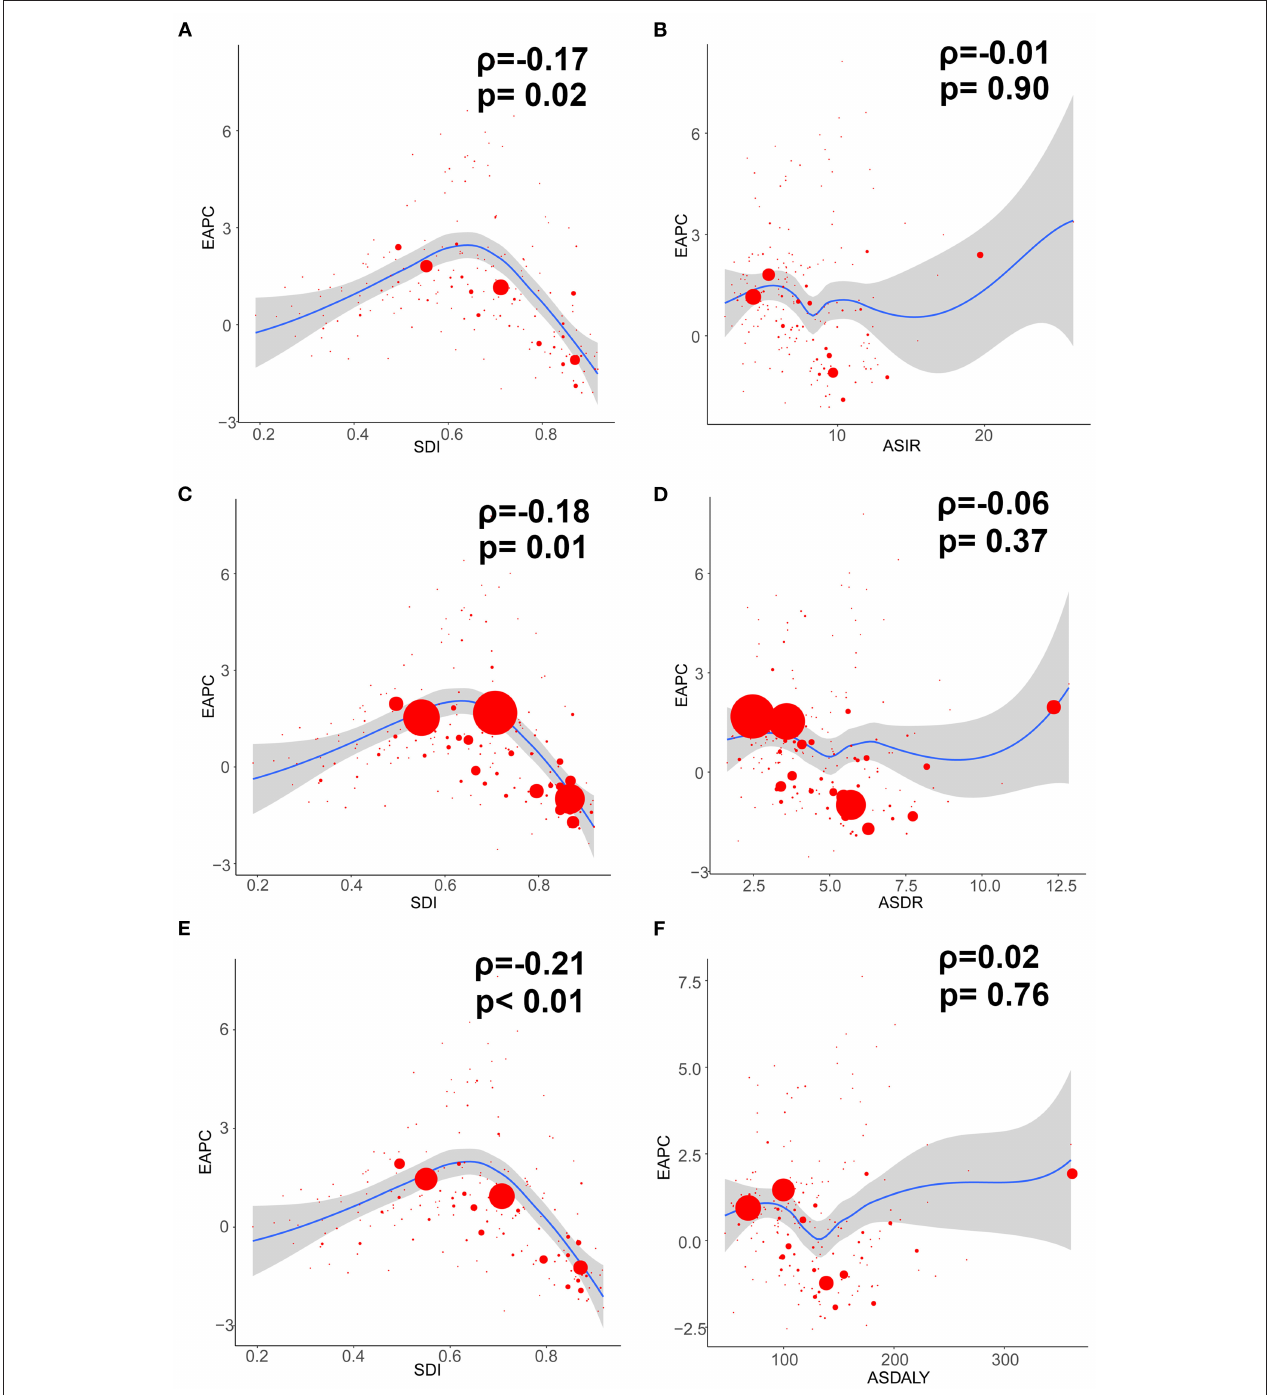
FIGURE 3 | The correlation between EAPC and ovarian cancer ASR (per 100,000) in 1990 as well as SDI in 2017. The circles represent countries and territories that were available on SDI data. The size of circle is increased with the cases of ovarian cancer. The R and P -values presented were derived from Pearson correlation analysis. (A) EAPC and SDI in incidence; (B) EAPC and ASIR; (C) EAPC and SDI in death; (D) EAPC and ASDR; (E) EAPC and SDI in DALYs; (F) EAPC and age-standardized DALY rate. ASIR, age standardized incidence rate; ASDR, age standardized death rate; EAPC, estimated annual percentage change; SDI, socio-demographic index; DALY, disability adjusted